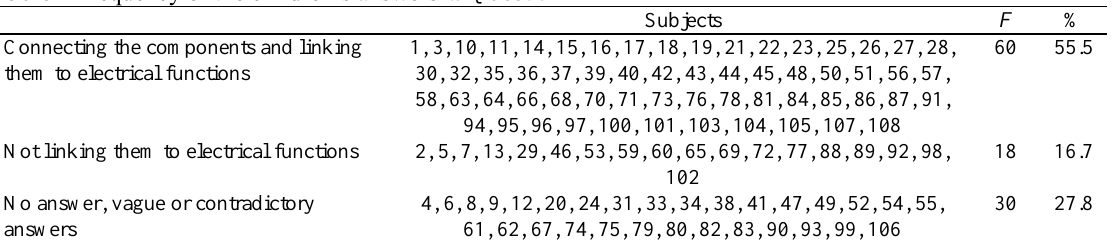
Table 2 Frequency of the children’s answers to Question 2